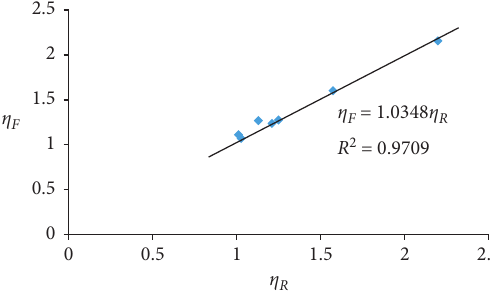
Figure 5: The correlation diagram of η